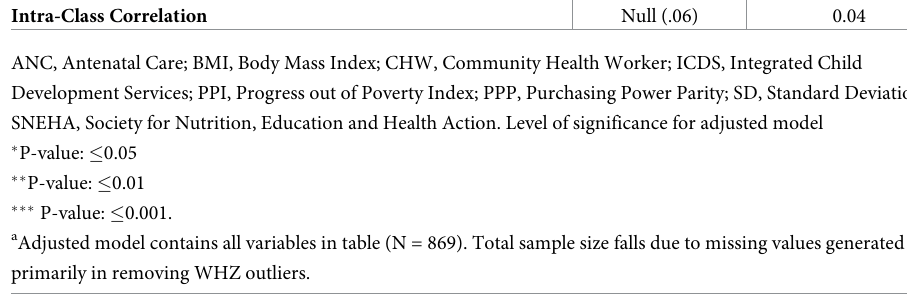
Table 3. Child, maternal, and socioeconomic characteristics of infants by enrolment status in a community-based child nutrition program in informal settlements of Mumbai, India. Characteristics